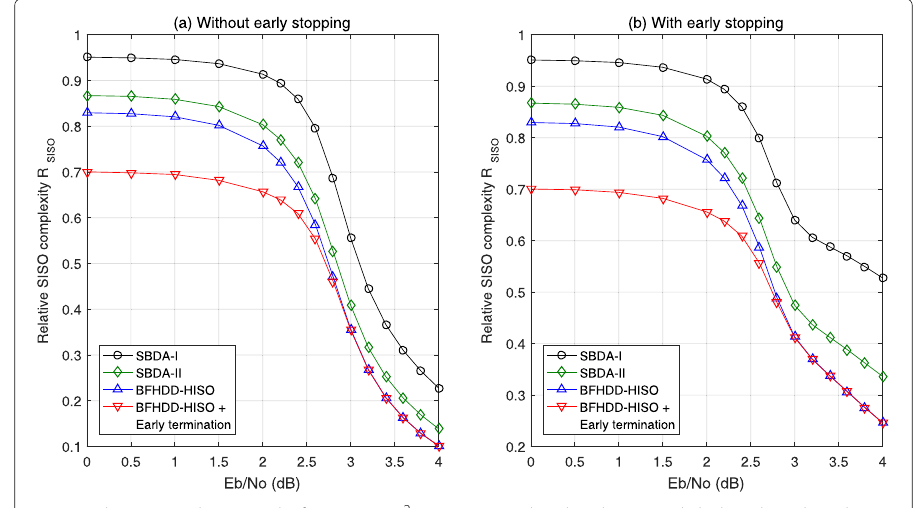
Fig. 8 Relative complexity results for ( 64,57,4 ) 2 TPC compared to the Chase-Pyndiah decoding algorithm [2] in terms of the SISO decoding requirements. a Without early stopping. b With early stopping. ( I max ,8; LRB number, 4)